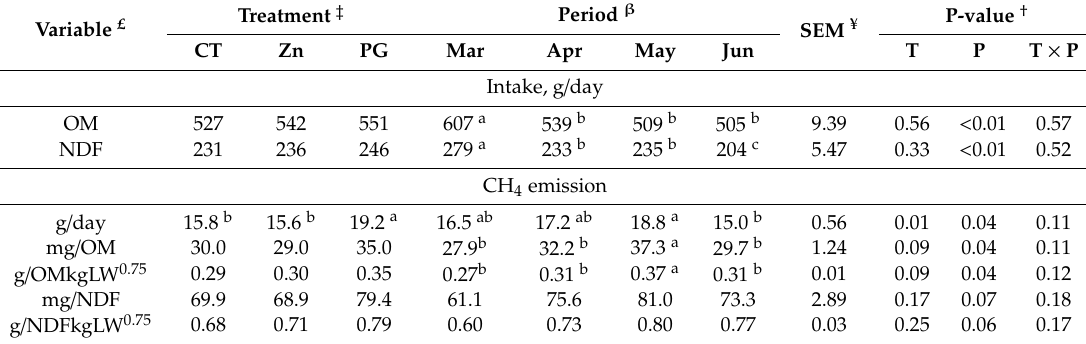
Table 3. E ff ect of zinc or propylene glycol supplementation on nutrient intake and CH 4 emission in sheep on Caatinga -native